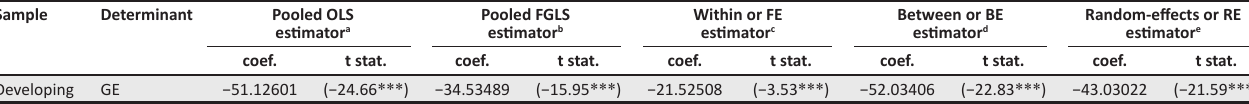
TABLE 10: Variation of Corruption Perceptions Index depends on government effectiveness, by stage of development: Developed. Sample